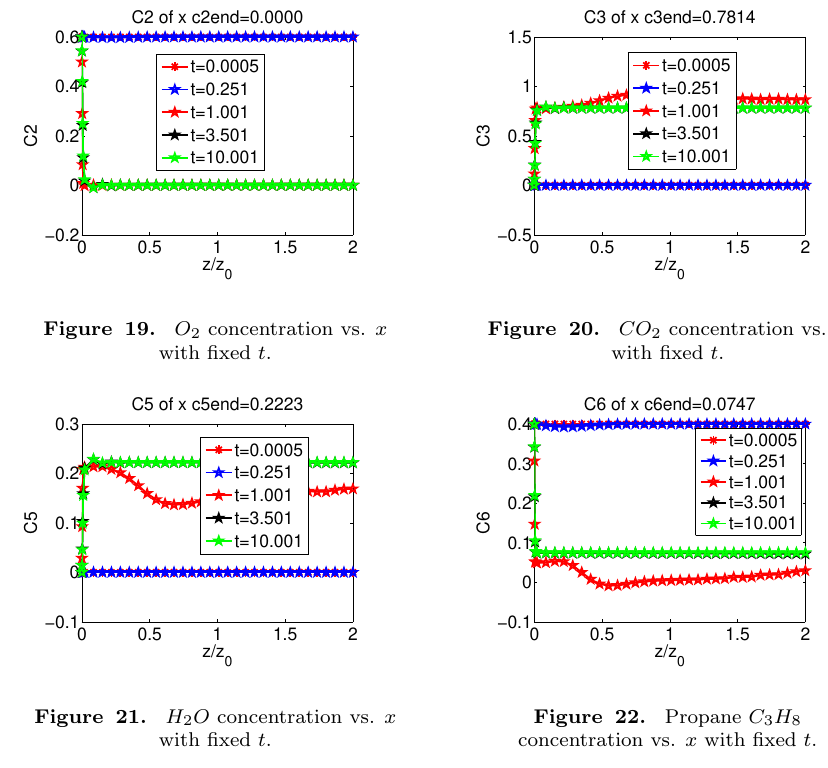
Figure 19. O 2 concentration vs. x with fixed t .